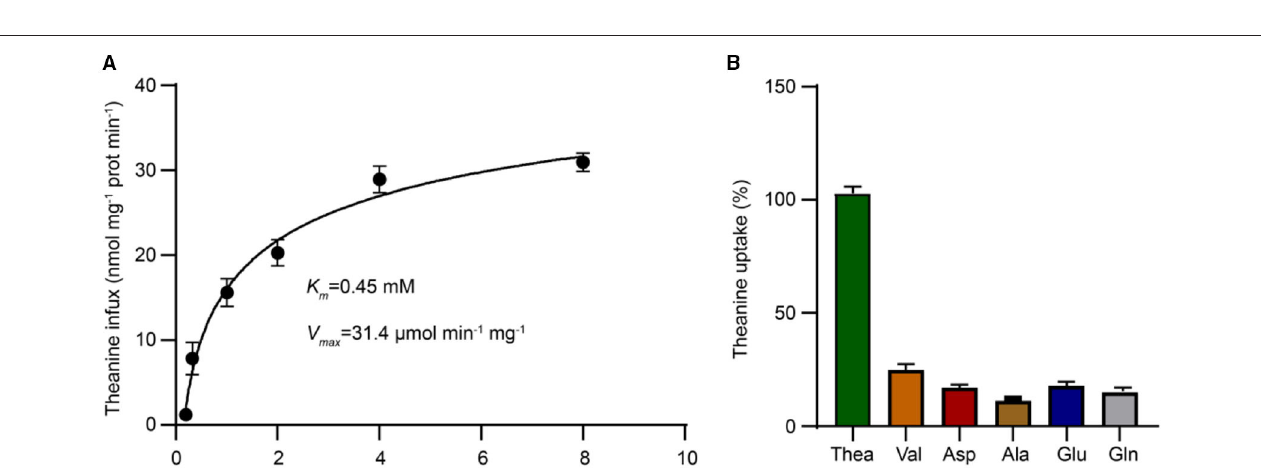
FIGURE 4 | The uptake kinetic properties and substrate selectivity analysis of theanine transport by CsCAT2. (A) Measurement of K m and V max values of CsCAT2 for theanine in yeast. The ordinate represents the amount of theanine absorbed by per milligram protein per minute. Prot represents protein. (B) Substrate specificity of